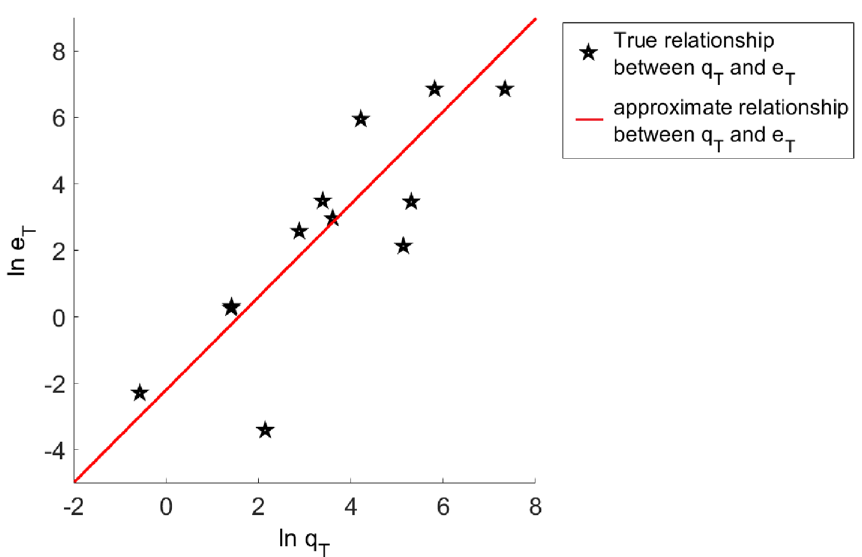
Figure 5. The relationship between fitness function q T and parameter error e T